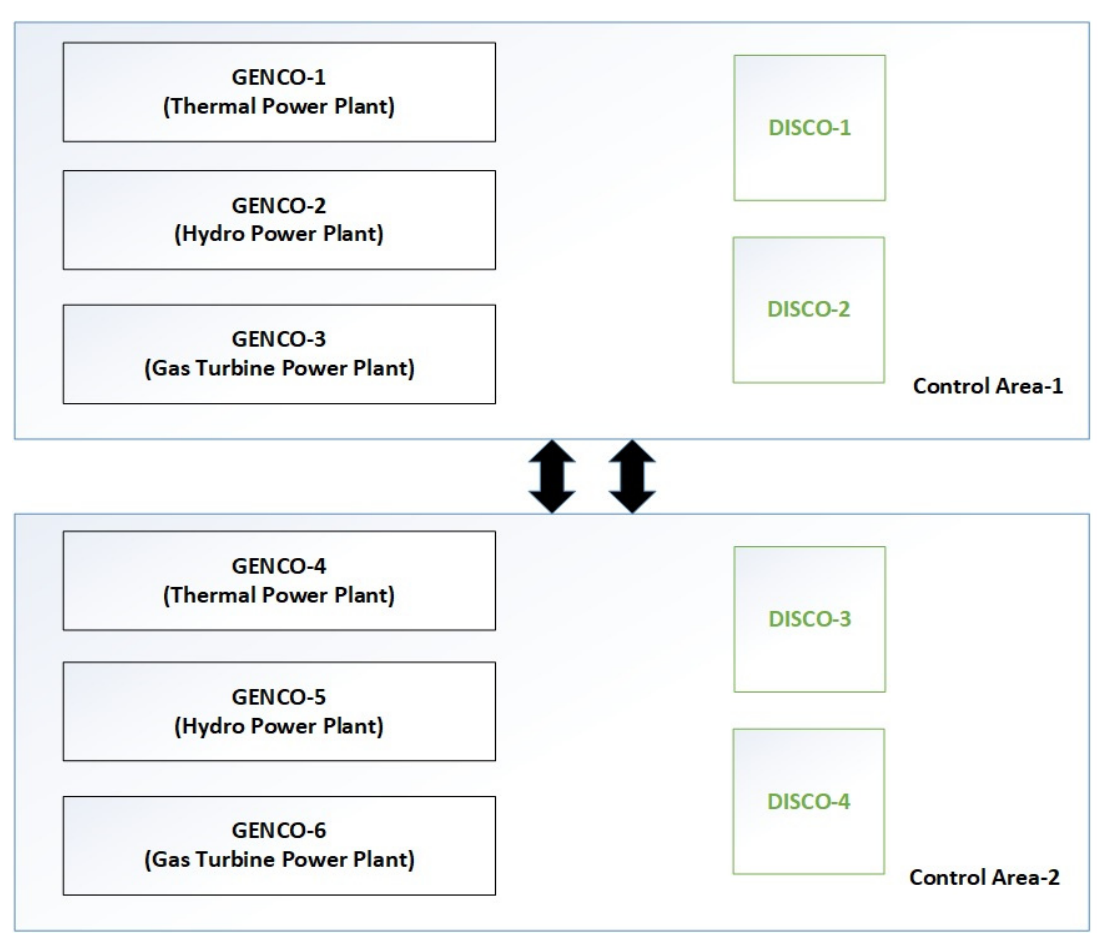
Figure 1. Pictorial representation of two-area deregulated power system.